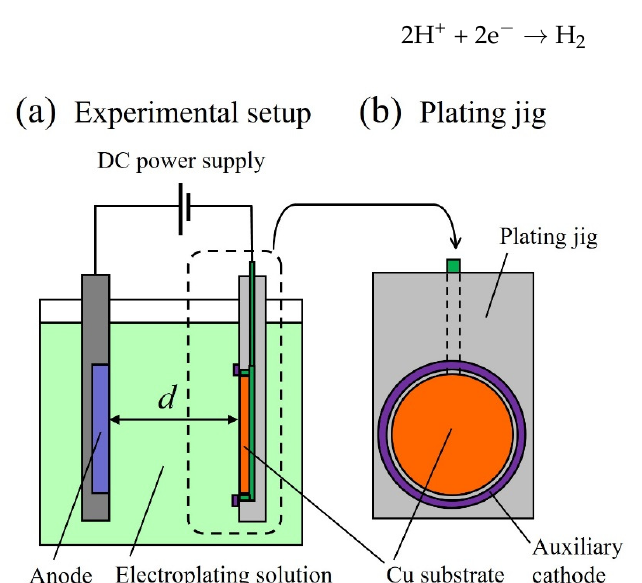
Figure 2. ( a ) is Experimental setup for electroforming. A Cu plate was used for the cathode, and a Ni anode plate containing sulfur was used for the anode, while d is the distance between the cathode and anode. ( b ) is Plating jig and the auxiliary cathode was installed at the periphery of the facility to ensure uniform film thickness. Table 1. Bath composition for Ni electroforming.